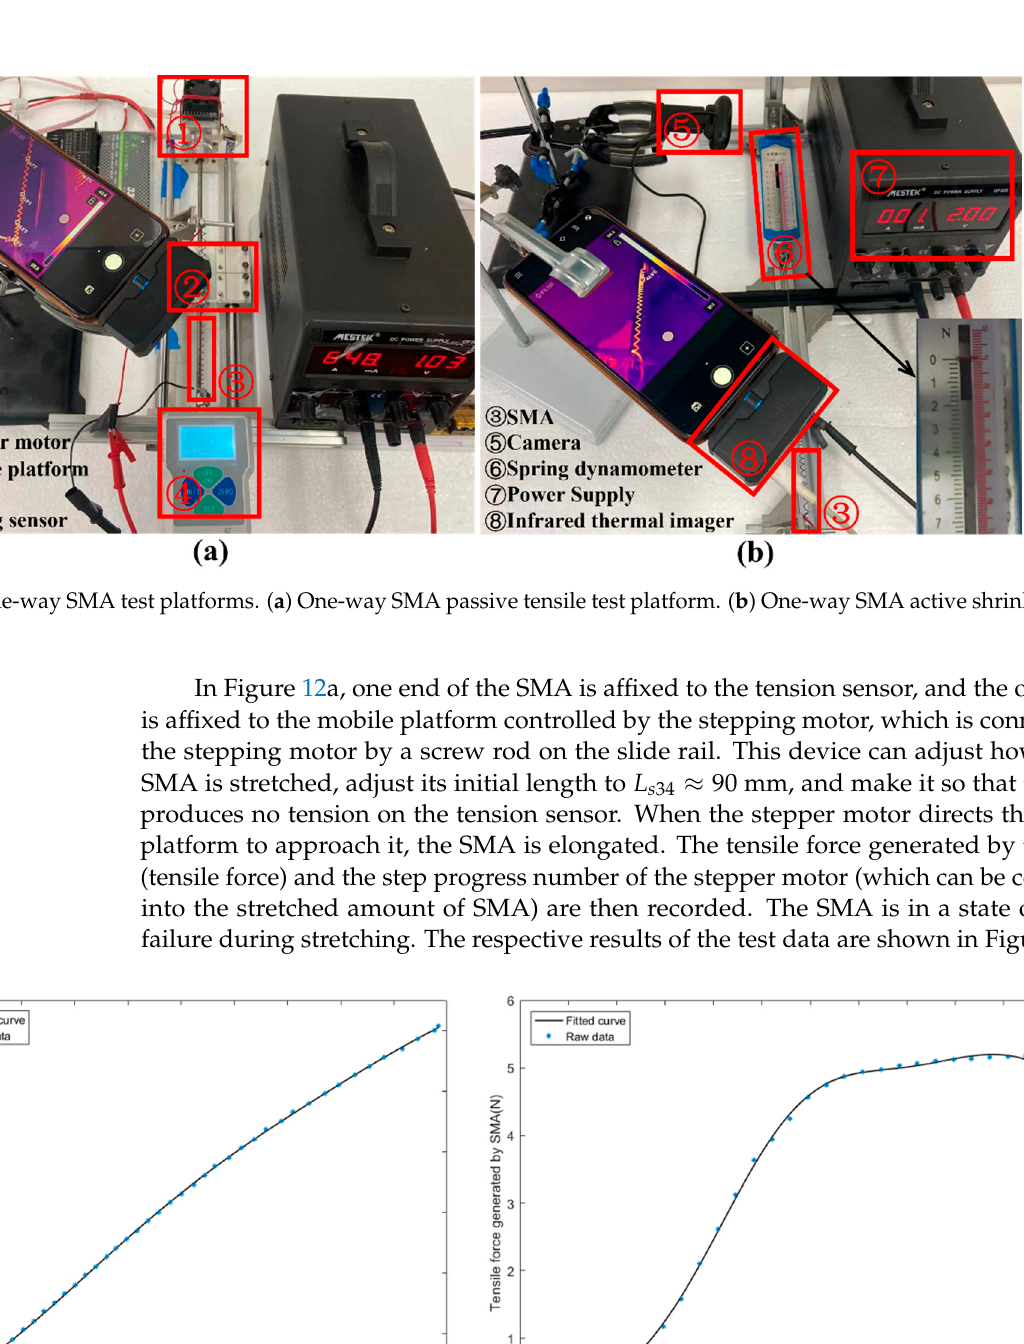
11 of 20 Figure 11. ISB-MWCR real machine test hardware system diagram.